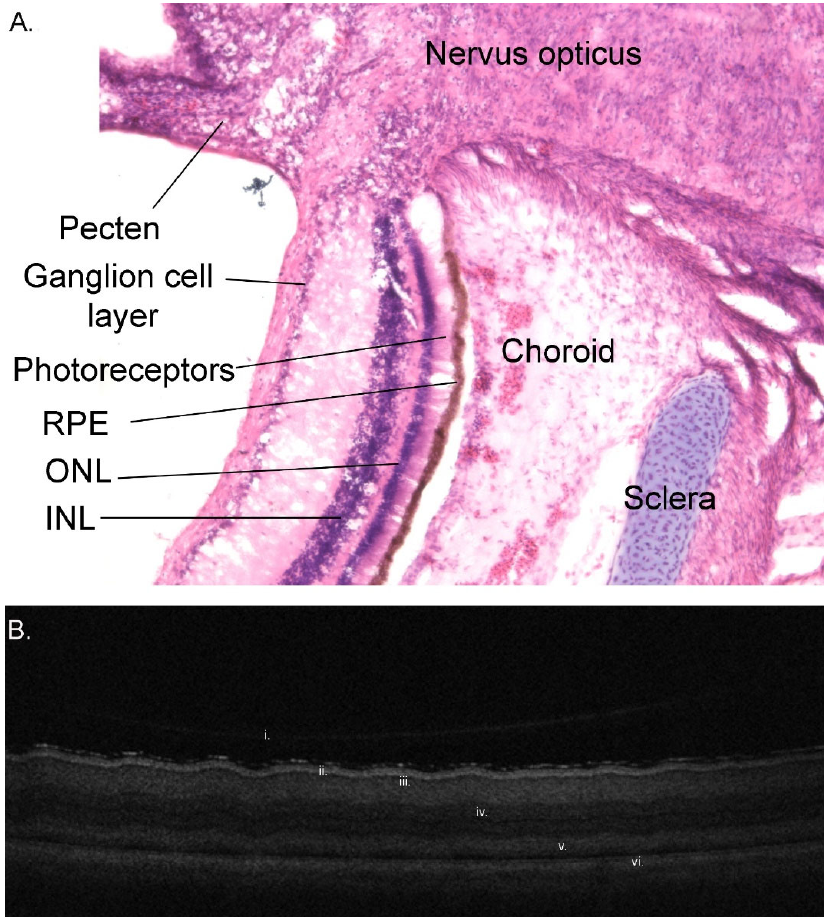
Figure 8. The posterior segment of the eye of a 7-week-old gentoo penguin chick ( Pygoscelis papua ). ( A ) Haemotoxylin and eosin-stained frozen section adjacent to the optic disc. Note the layered structure of the retina (ONL = outer nuclear layer, INL = inner nuclear layer), underlain by the retinal pigment epithelium (RPE) and the cartilaginous component of the sclera, as well as the vascular pecten intruding into the vitreous cavity; ( B ) Optical coherence tomogram (OCT) of the central retina, showing many of the same layers: i. posterior vitreous base; ii. nerve fibre layer, iii. ganglion cell layer; iv. Inner nuclear layer; v. photoreceptors; vi. retinal pigment epithelium. No foveal dip was visible in any section either histologically or on OCT. Credit: